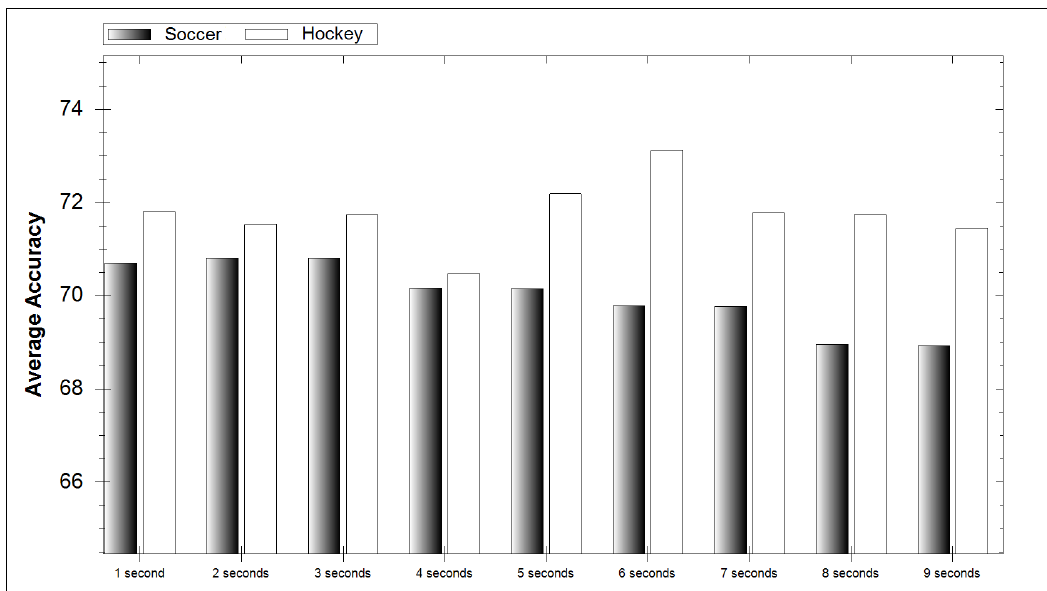
Figure 6. Effect of window length on average